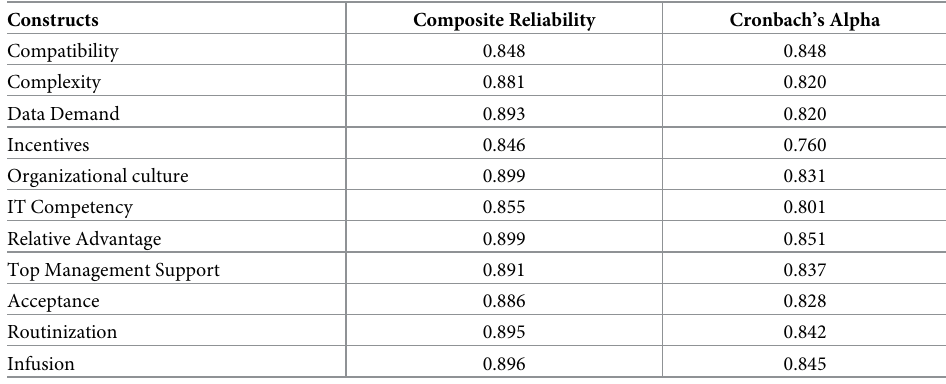
Table 5. Composite reality index and cronbach’s alpha in internal consistency